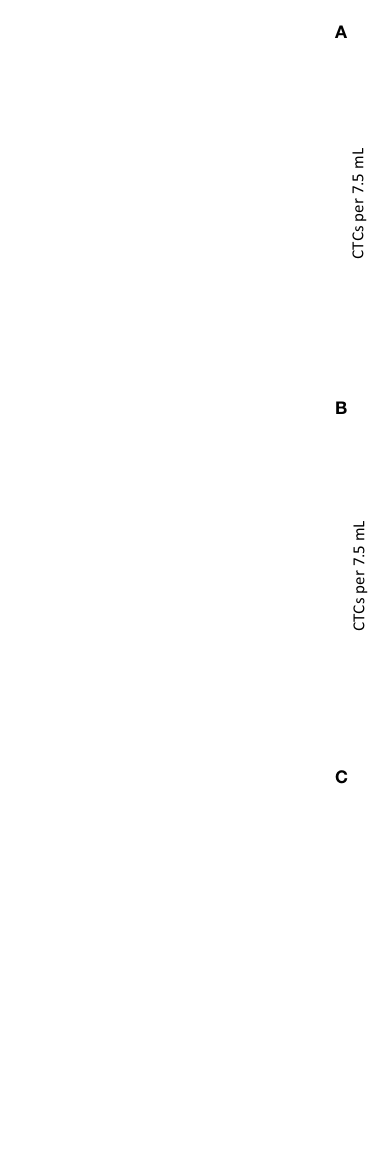
which did not drain a known solid tumor, were comparable to those in a peripheral sample (PE).